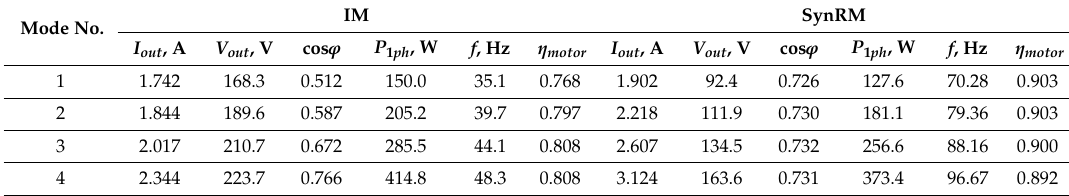
Table 5. Performance of motors during the pump operating points of Table